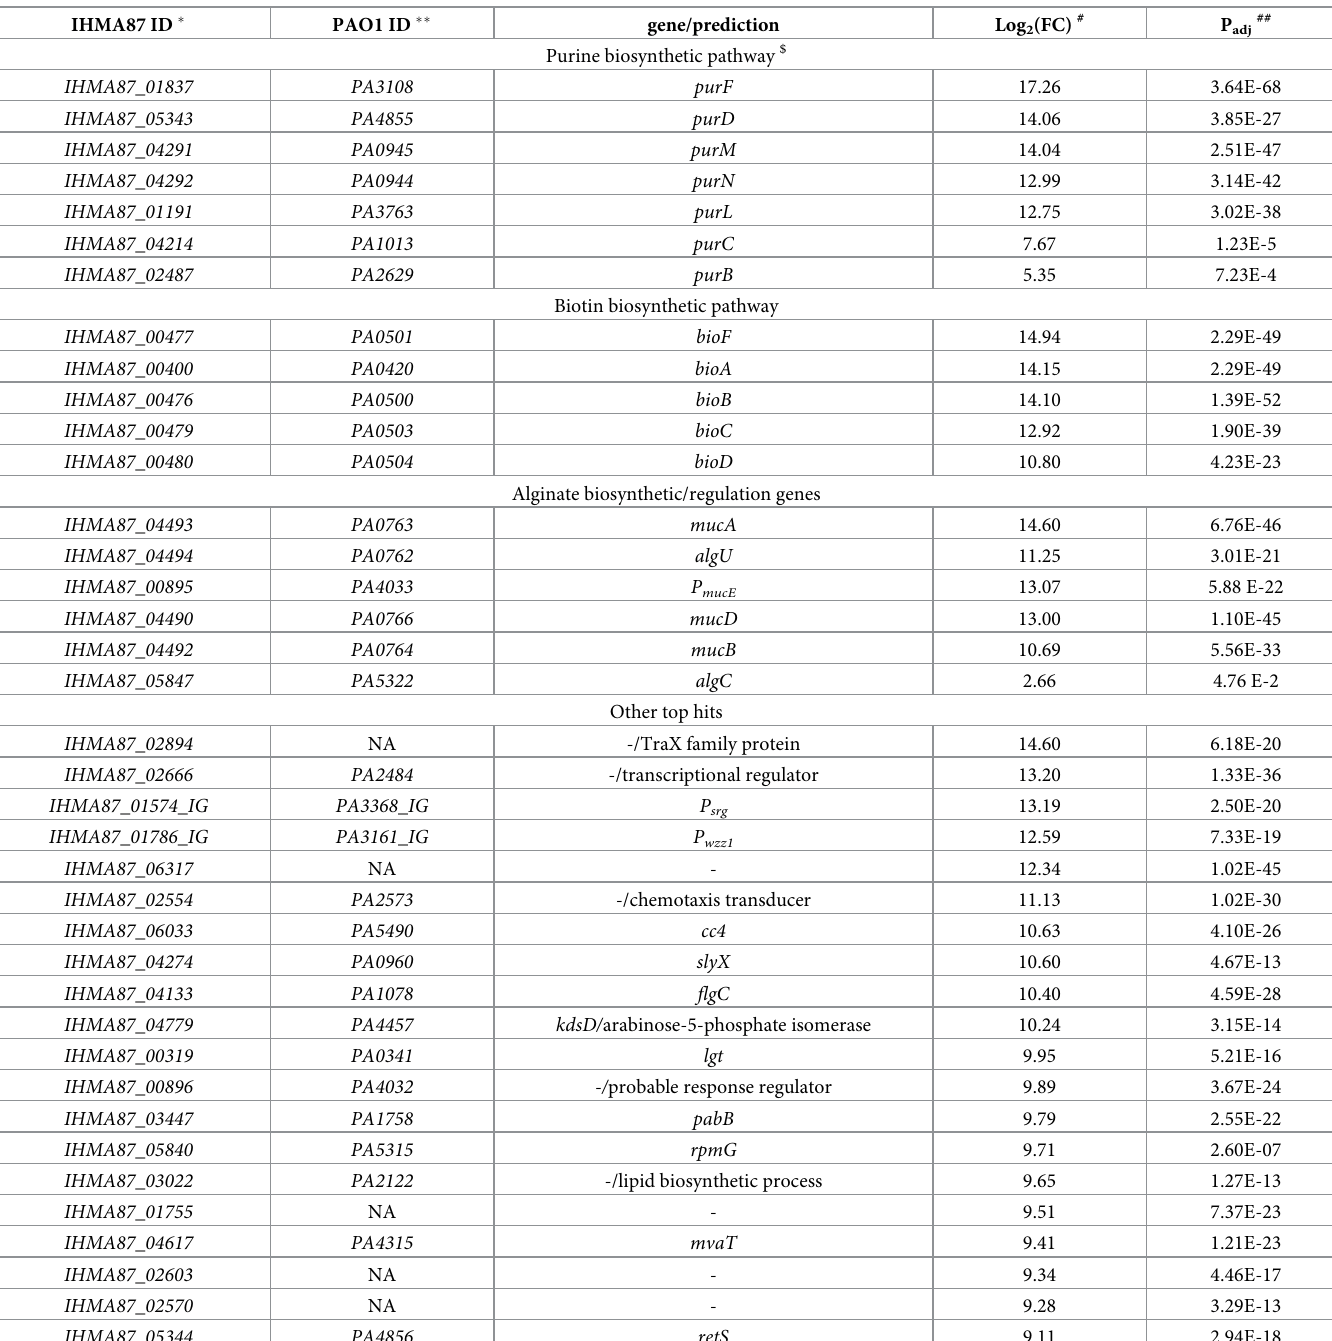
Table 1. Mutants enriched in plasma compared to HIP carry insertions in three main pathways. IHMA87 ID